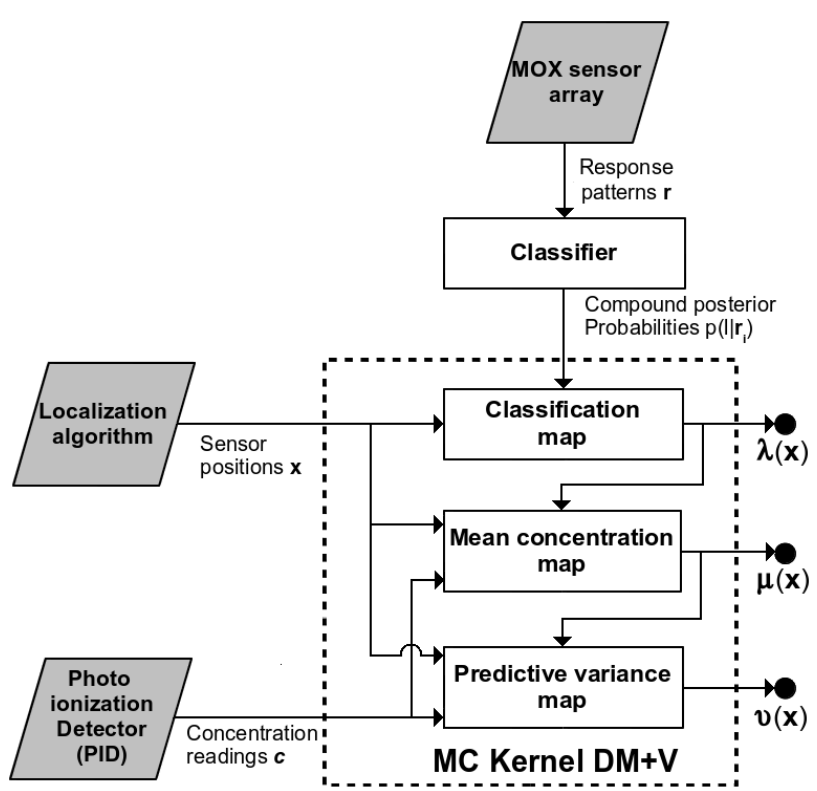
Figure 1. MC Kernel DM+V block